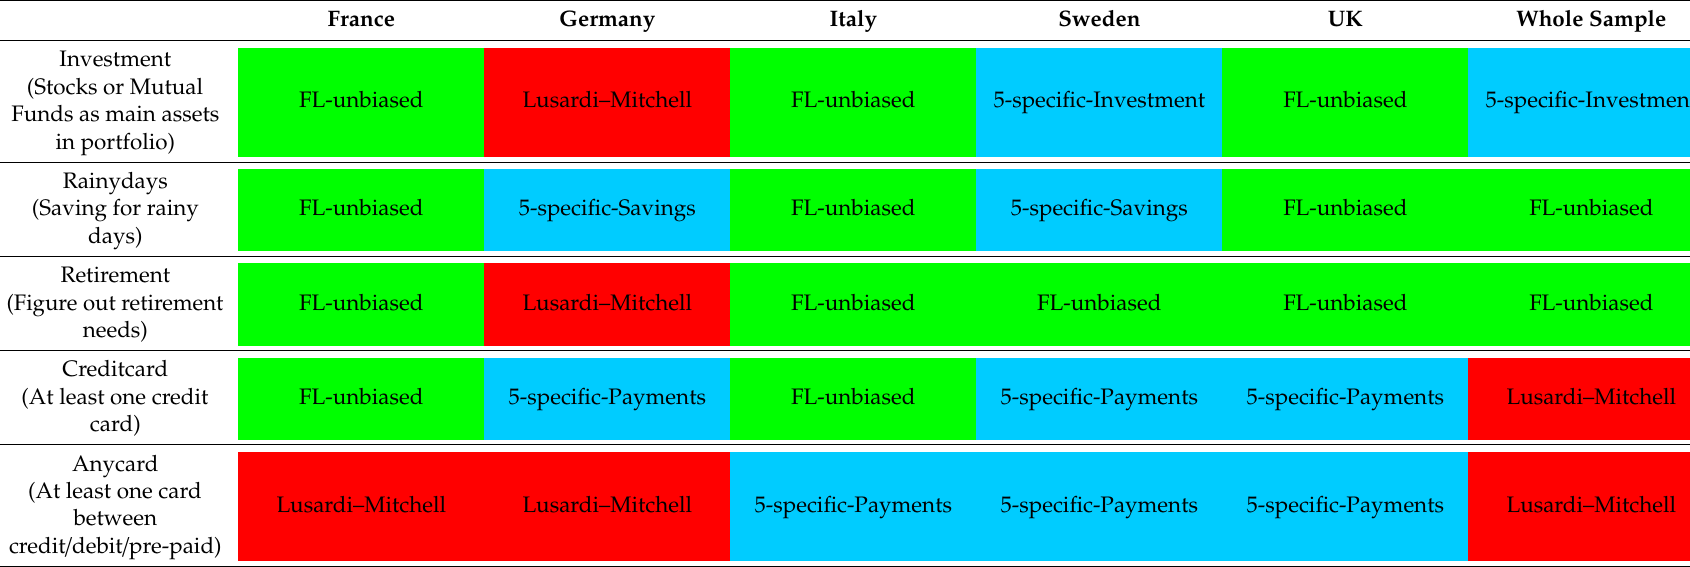
Table 4. Summary of results: best performing financial literacy measures for each country-and-behavior